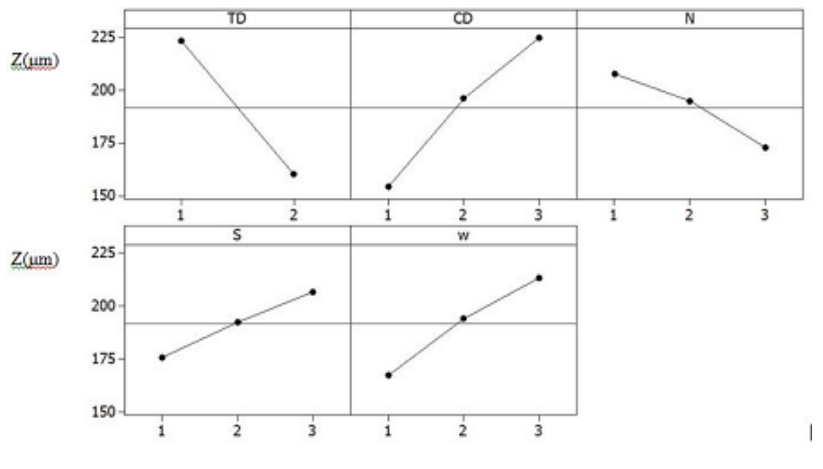
Fig. 9. The main effects